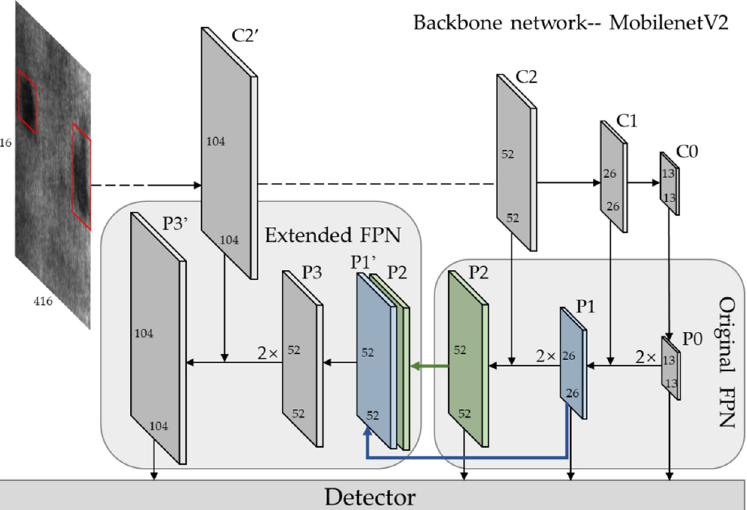
Figure 3. Structure of improved MobileNet-YOLOV3 network. Here Ci denotes the feature map form backbone, and Pi denotes the corresponding feature pyramid layer on FPN/EFPN. The dash line between C2’ and C2 means C2’ and C2 are derived from the same stage and share the same weights. P1, P2 and P3 are origin FPN layers. FFM module integrates P3 from P1 and P2, and then through an top-down framework EFPN to form the extended detection layer P3’. The FPN layers (P0, P1, P2, P3’) will be fed to the following detector to futher detection.